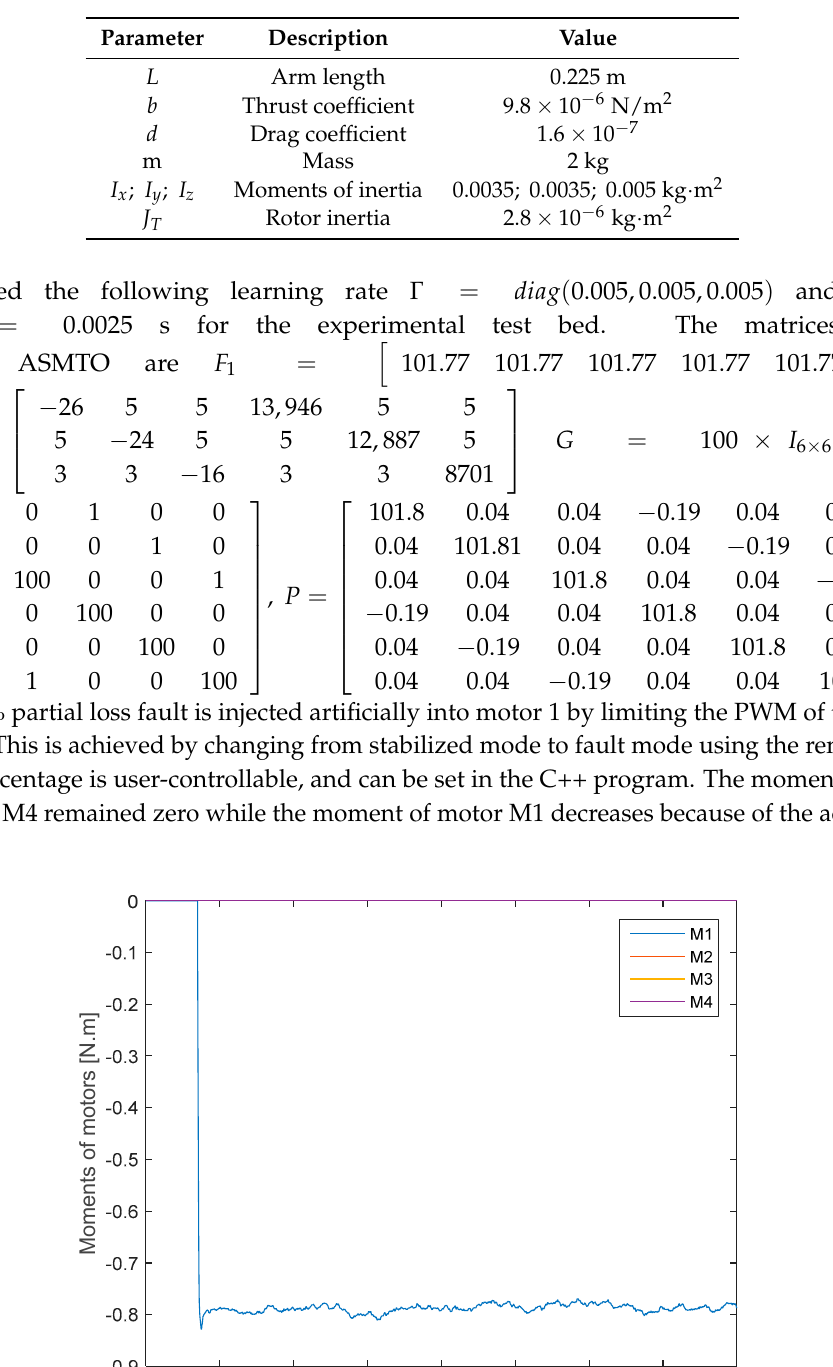
Table 1. DJI F450 quadcopter parameters.